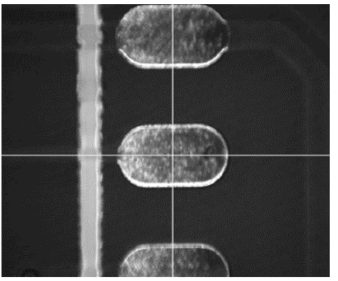
Figure 8. Display of the light output position.